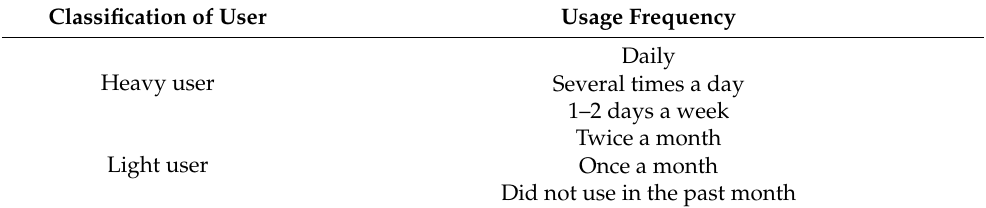
Table 2. Classification of mHealth users.